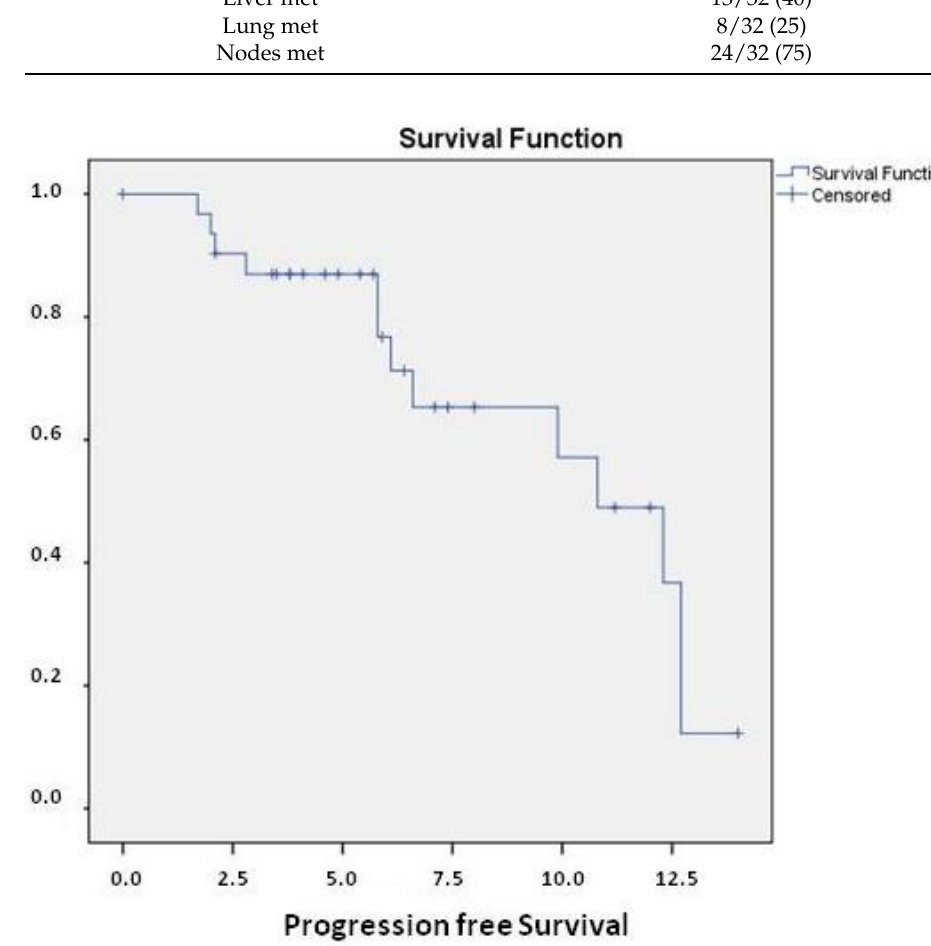
Figure 1. median Progression Free Survival (mPFS) in the overall population was 10.8 months (95%CI